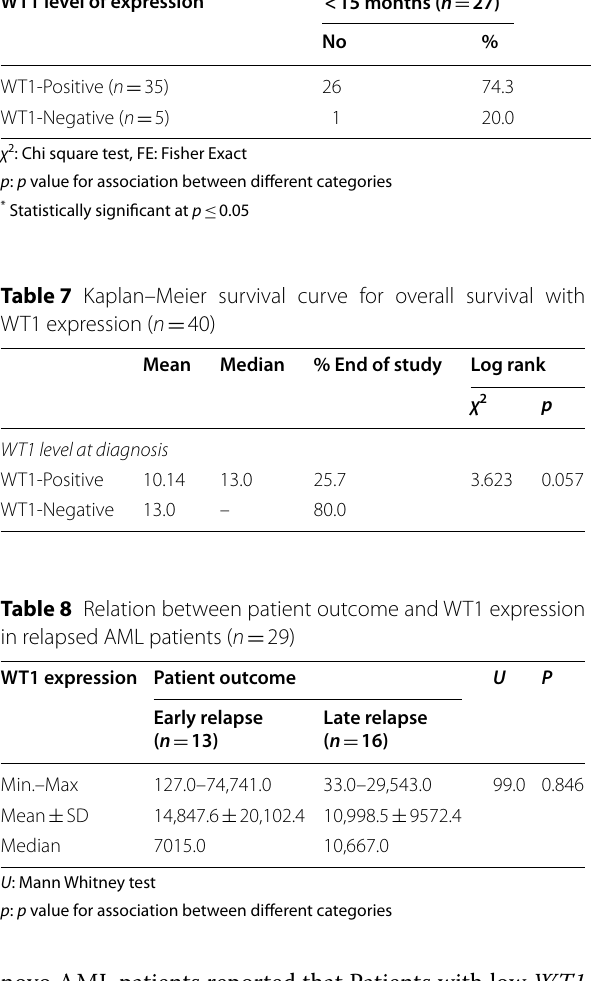
Table 6 Relation between overall survival (OS) and WT1 expression at diagnosis ( n